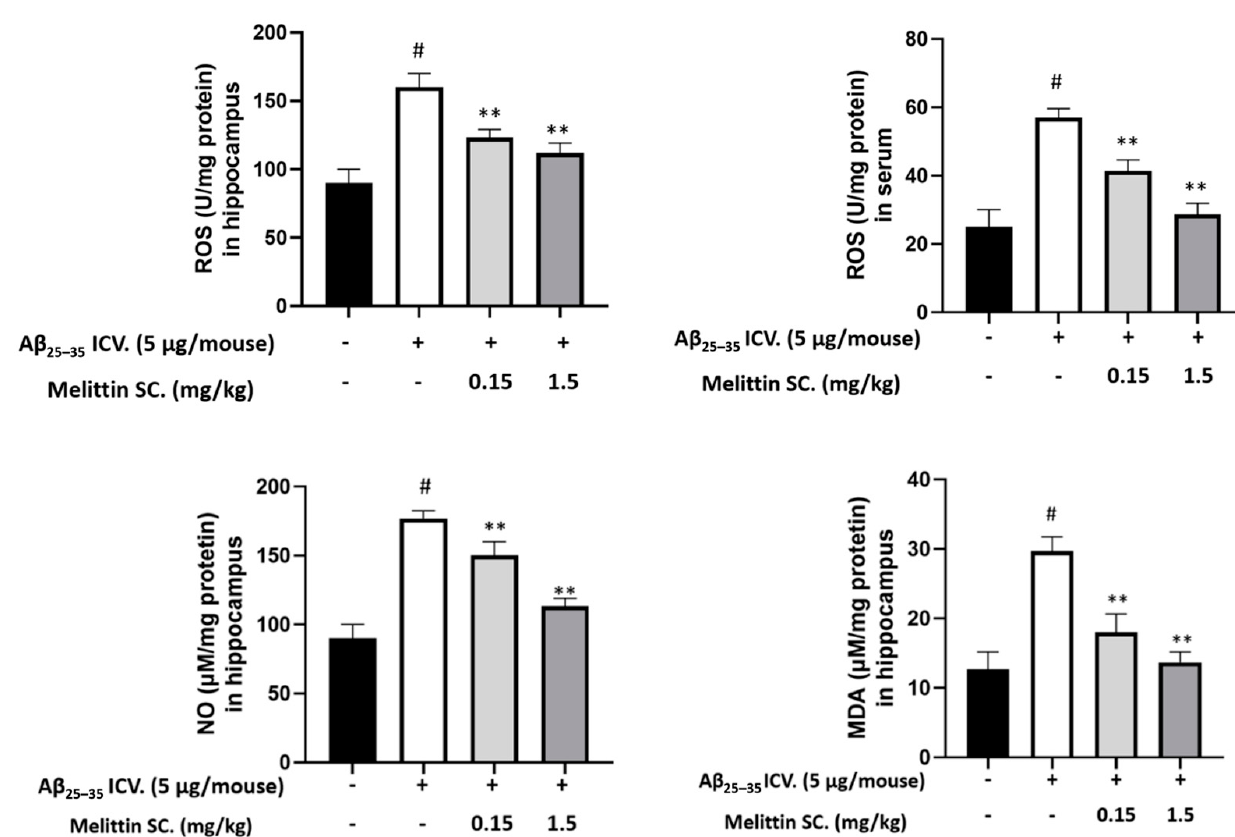
Figure 8. Major antioxidant parameters were examined in in vivo samples. The result showed that A β 25–35 ICV. treatment significantly increased oxidative stress in the hippocampus and serum, which was reversed by melittin treatment. To conduct this experiment: Hippocampus tissue and serum were prepared, and ROS, NO, and MDA levels were examined as described in the materials and methods section. Data are presented as the mean ± standard error of the sextuple determinations. # p < 0.01 vs. control ** p < 0.01 vs. A β 25–35 only treated group.